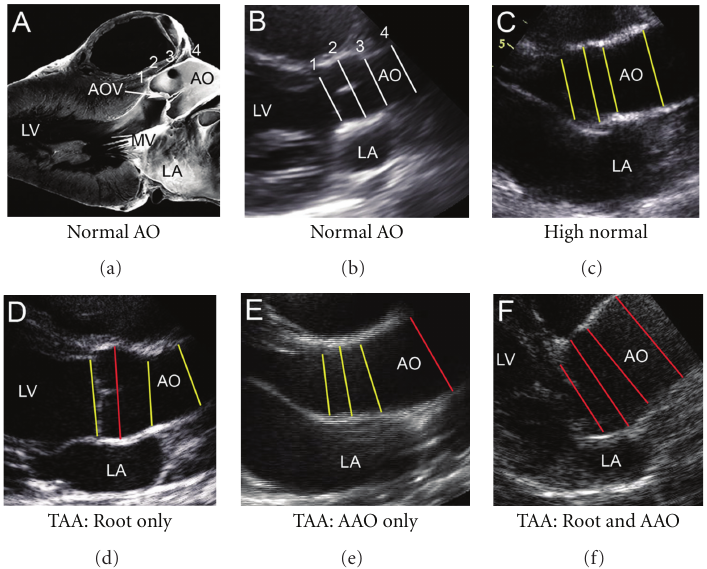
Figure 2: Spectrum of thoracic aortic aneurysm. Pathologic specimen identifies aortic dimensions (1–4) and intimate anatomic relationship of aortic valve and thoracic aorta (a). Parasternal long-axis echocardiographic views of the proximal aorta demonstrating the aortic valve annulus (1), aortic root (2), sinotubular junction (3), and ascending aorta (4) dimensions in normal (b) and discrete patterns of disease (c–f). Some patients are characterized by “high normal” dimensions throughout the proximal aorta (yellow lines, (c)), for example, patients with BAV. TAA may manifest as isolated dilation of the aortic root (red line, (d)), isolated dilation of the ascending aorta (red line, (e)), or dilation of multiple dimensions (red lines, (f)). AOV: aortic valve; AO: aorta; LA: left atrium; LV: left ventricle; MV: mitral valve. Reproduced with permission